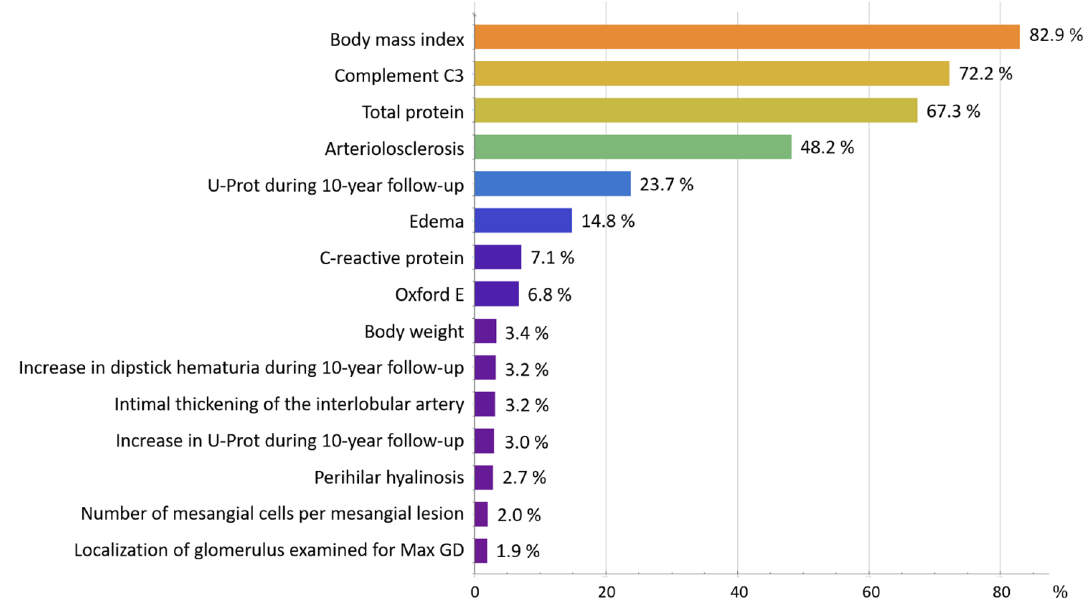
Figure 4. Frequencies (GP): Frequently utilized predictive variables in selected models using SR via GP. The 15 most frequently utilized predictive variables in 1819 predictive functions, which are selected among 19,437 models generated in the leave-one-out cross-validation using symbolic regression via genetic programming, are listed in descending order. The horizontal axis represents the appearance frequencies [Frequencies (GP)]: the percentage at which each predictive variable is utilized in all 1,819 predictive functions. Abbreviations: GP, genetic programming; SR, symbolic regression; C3, component 3; U-Prot, urinary protein excretion; Oxford E1, the presence of endocapillary hypercellularity; MaxGD, maximal glomerular diameter.